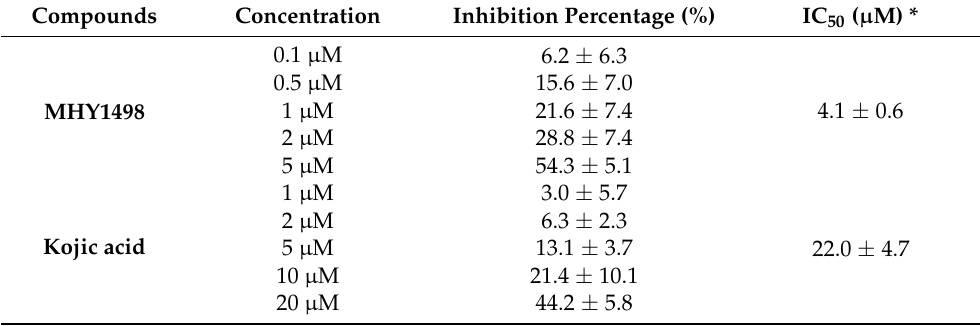
Table 2. Inhibitory effects on mushroom tyrosinase activity and related IC 50 values of kojic acid and MHY1498.